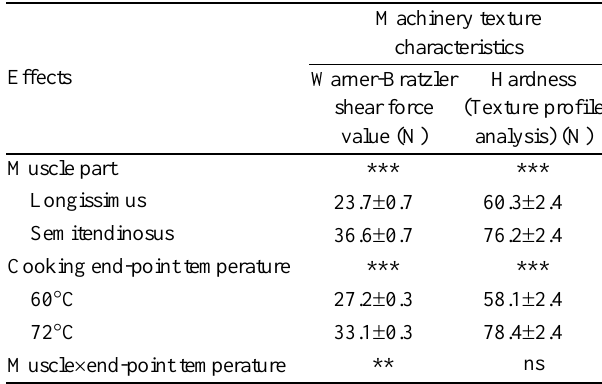
Table 3. Effects of muscle part and cooking